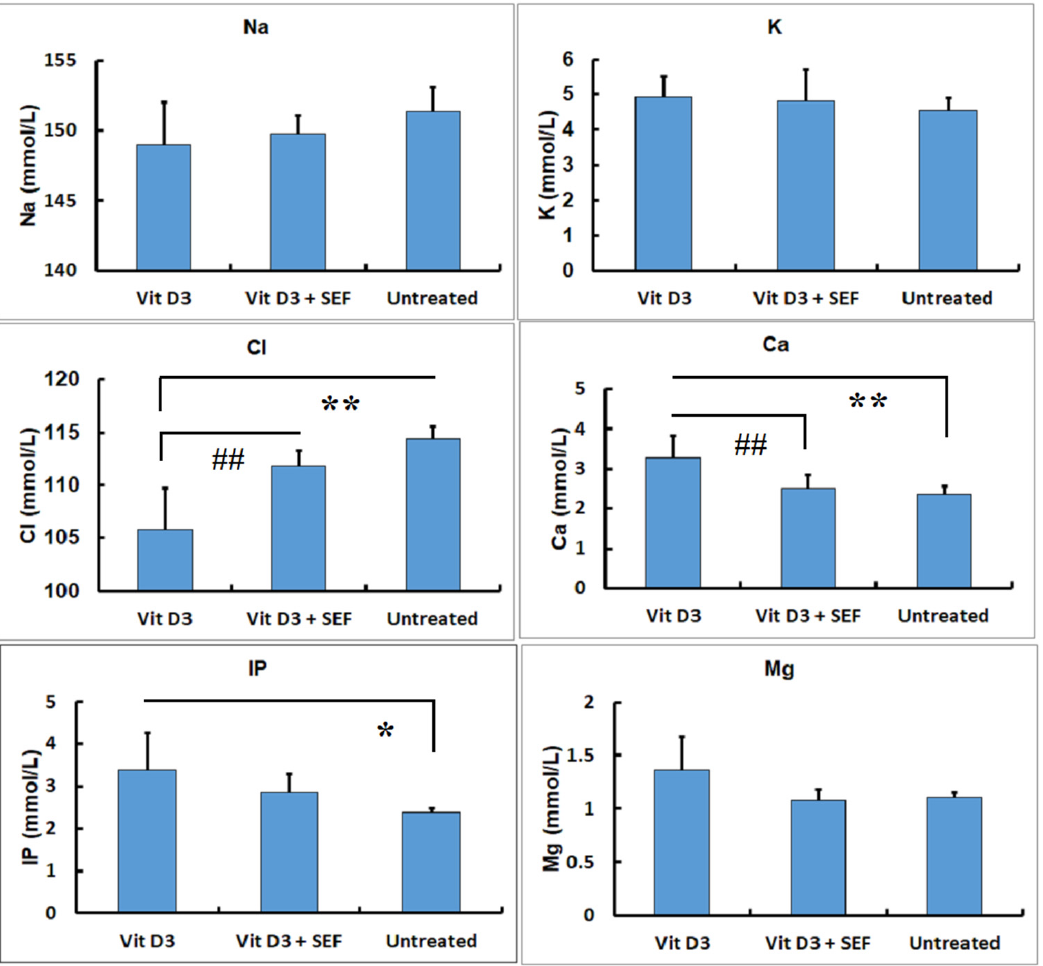
Figure 3. Serum biochemical findings in electrolytes (Na, K, Cl, Ca, inorganic phosphorus (IP), and Mg). Decreased Cl concentrations and increased Ca and IP concentrations are seen in the Vit D 3 -treated group. *: Significantly different from the Vit D 3 + SEF-treated group and the untreated group ( p < 0.05). **: Significantly different from the Vit D 3 + SE-treated group and the untreated group ( p < 0.01). ## : Significantly different from the Vit D 3 + SEF-treated group and the untreated group ( p <